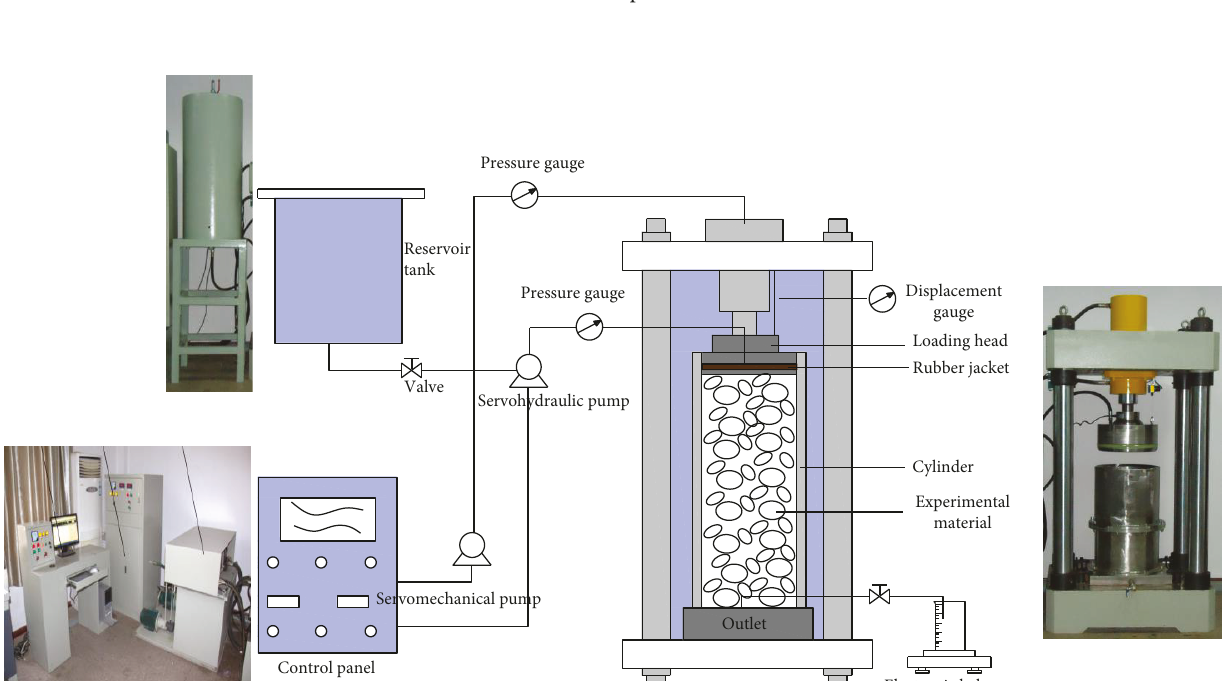
Figure 1: Detail of experimental media.